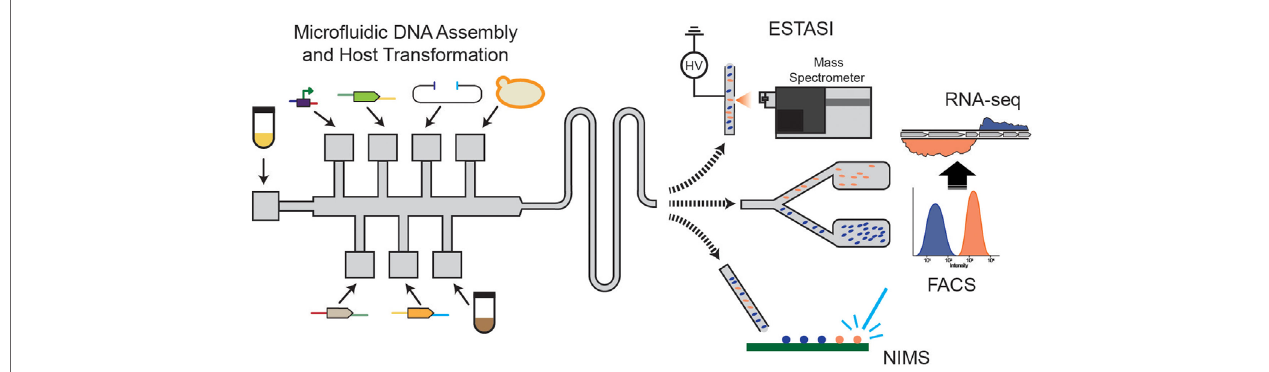
FiGURe 5 | Developing microfluidic assays for metabolic engineering with FACS-RNA-seq, nanostructure initiator mass spectrometry (NiMS), and electrostatic spray ionization (eSTASi) mass spectrometry analysis for high-throughput, small volume analysis